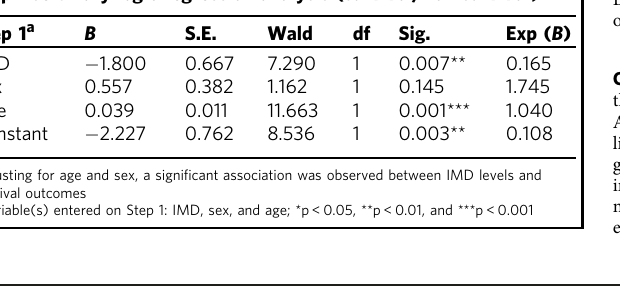
Table 1 Stepwise binary regression analysis Stepwise binary logic regression analysis